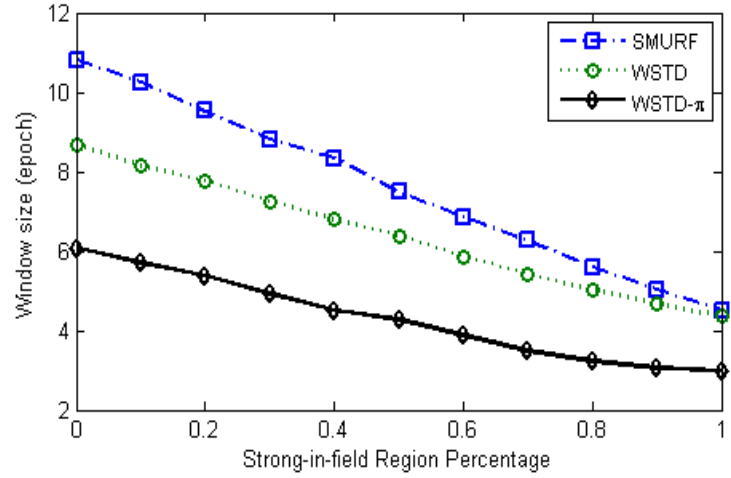
Figure 22. Comparison of variable window schemes’ cleaning window sizes as the StrongPercentage parameter is